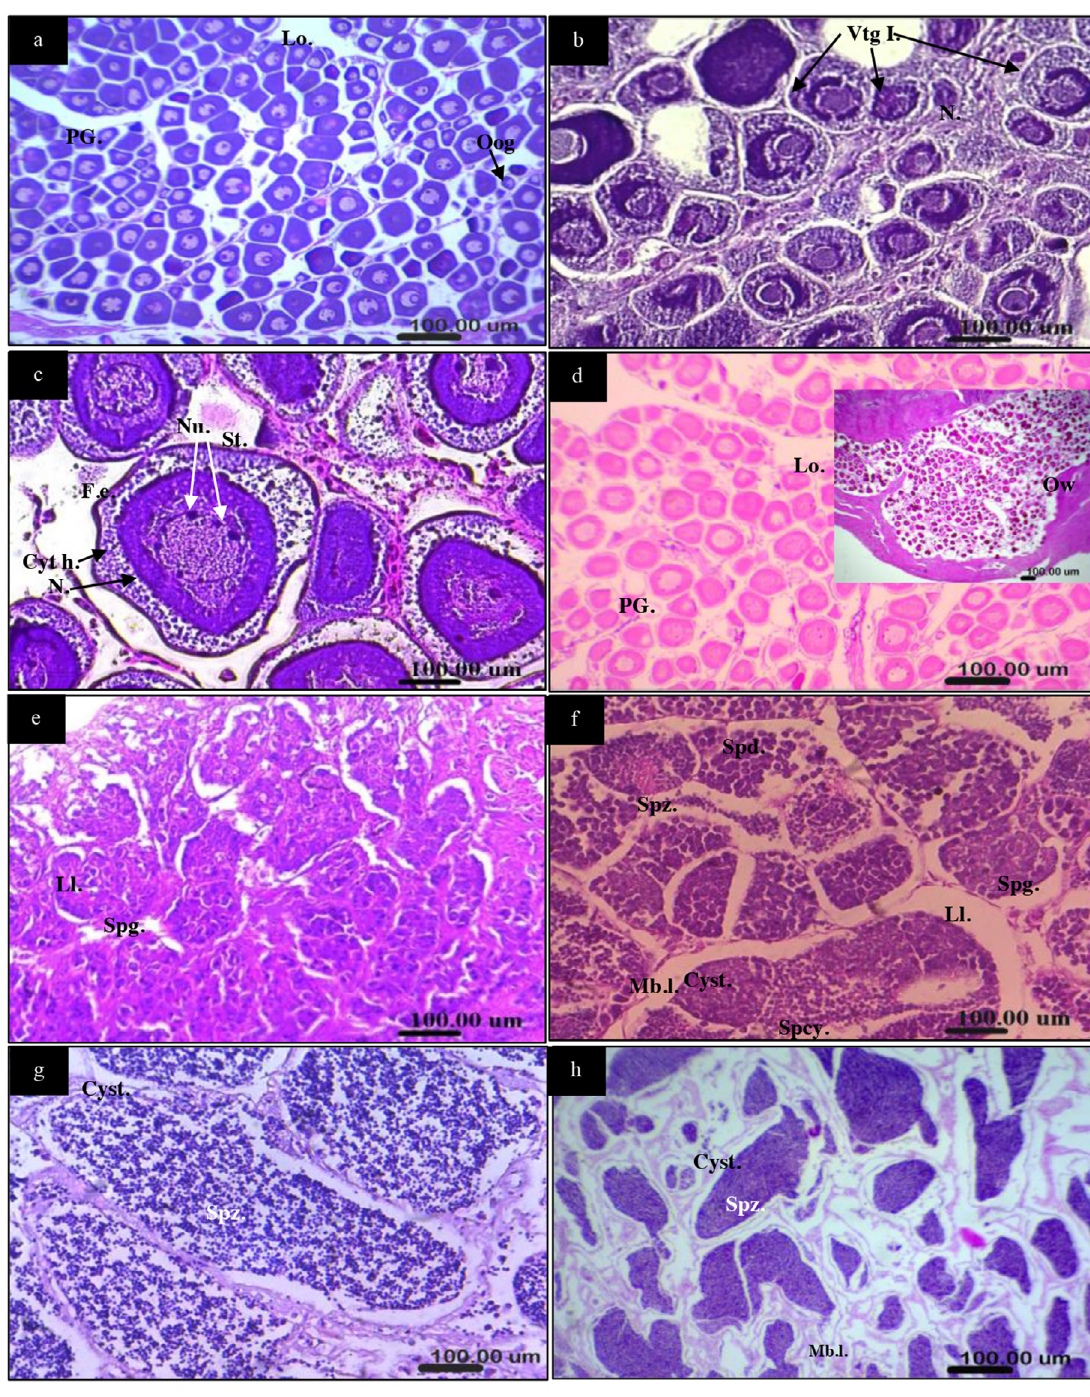
Fig. 11. Abbreviation: Oog. Oogonia, PG. Primary growth oocyte, Nu. Nucleoli, F.e. Follicular envelope, Lo. Ovarian lumen, VtgI. Primary vitellogenic oocyte, N. Nucleus, Cyt.h. Heterogeneous cytoplasm, St. Ovarian stroma. Ow. Ovarian wall, Spg. Spermatogonia, L.l. Lobular lumen, Cyst. Cyst, Mb.l. The basal membrane of the lobule, Spcy. Spermatocyt, Spd. Spermatid, Spz. Spermatozoa. Histological sections through the gonads of P. blennoides showing different development phases (scale: 100 m m). a. General view of immature female (Gx10, caught 30/04/15, TL: 53.1cm; WG: 3.86g, GSI: 0.396). b. Developing female (Gx40, caught 21/12/15, TL: 27.3cm; WG: 0.12g, GSI: 0.601). c. Early maturing female with initial stage of vitellogensis and yolk protein (Gx40, caught 29/06/15, TL: 45.1cm, WG: 3.9g, GSI: 0.601). d. Histological section through the gonad of the biggest female sampled (Gx10, caught 23/04/2016, TL: 62.7cm, WG :10.54g, GSI: 0.61). Thick ovarian wall (Gx4) in regenerating ovaries. e. Immature male with spermatogonia cells (Gx40, caught 10/02/15, TL: 23.6cm, WG: 0.02g, GSI: 0.024). f. Male regenerating stage with the appearance of spermatids and spermatozoa (Gx40, caught 26/08/14, TL: 26.1cm, WG: 0.72g, GSI: 0.373). g. Developing testes (Gx40, caught 6/01/15, TL: 21.1cm, WG: 0.5g, GSI: 0.990). h. Mature testes with emission of spermatozoa (Gx10, caught 06/ 01/2015, TL: 24.1cm, WG: 1.23g, GSI: 2.13). Page 12 of